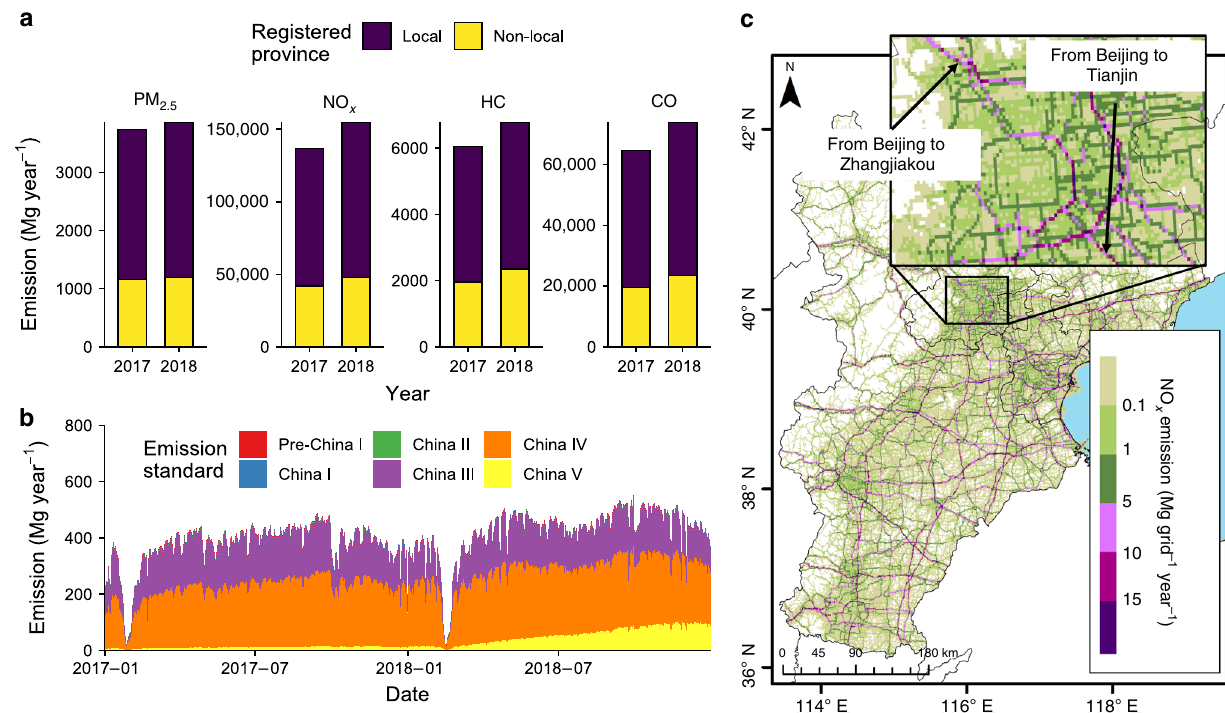
Fig. 1 Emissions in the Beijing – Tianjin – Hebei (BTH) region by heavy-duty trucks (HDTs) in 2017 and 2018. a Emission amounts of four air pollutants by place of HDT registration. b Day-to-day NO x emissions of HDTs and their contributions by emission standard. c High-resolution (0.01 ˚ × 0.01 ˚ ) maps of NO x emissions by HDTs in the BTH region, 2018. The subgraph is the core area of Beijing. *Source data are provided as a Source Data fi